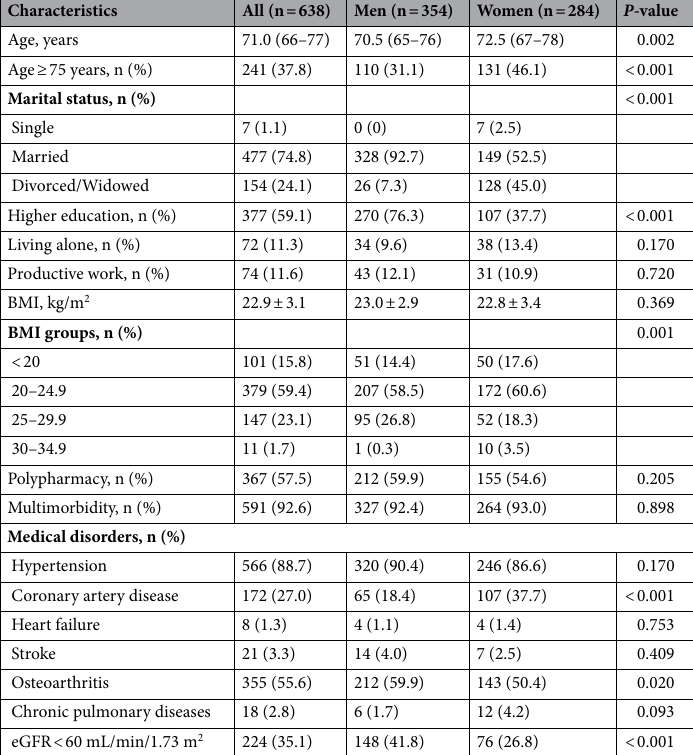
Table 1. Characteristics of the participants according to sex. Categorical variables are described as frequencies (n) and percentages (%). Age is presented as median and interquartile range (25–75th percentile). BMI is described using means and standard deviations. Chi-square test or Fisher’s exact test was used to compare categorical variables. The Student’s t-test was used to compare two means of BMI. The Mann–Whitney test was used to compare two medians of age. eGFR estimated glomerular filtration rate, BMI body mass